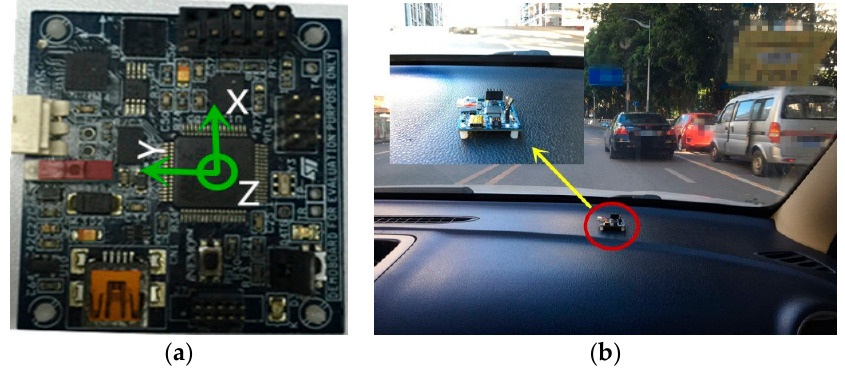
Figure 1. Setup of the board. ( a ) The axis pointing of motion sensor; ( b ) The placement of the board in the car.